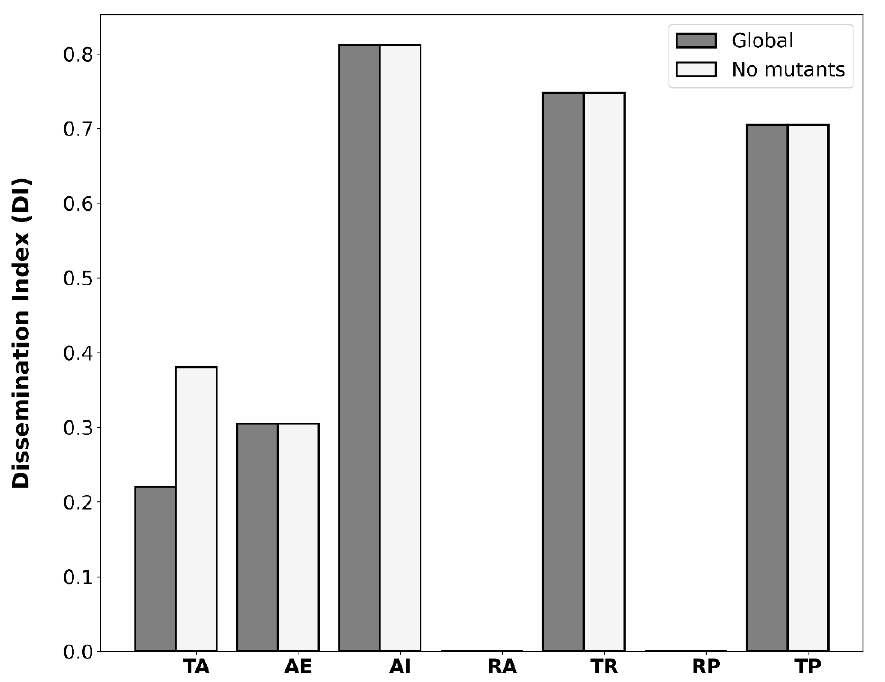
Figure 4. Bar plot of DI values aggregated on CARD Resistance Mechanism: target alteration (TA), antibiotic efflux (AE), antibiotic inactivation (AI), resistance by absence (RA), target replacement (TR), reduced permeability (RP) or target protection (TP). The dissemination status (in band, not in band) of each ARG homolog mapping to a given resistance mechanism is used for the computation of the aggregate DI value. The DI values of each resistance mechanism when removing any ARG homologs annotated as conferring resistance via mutation are also